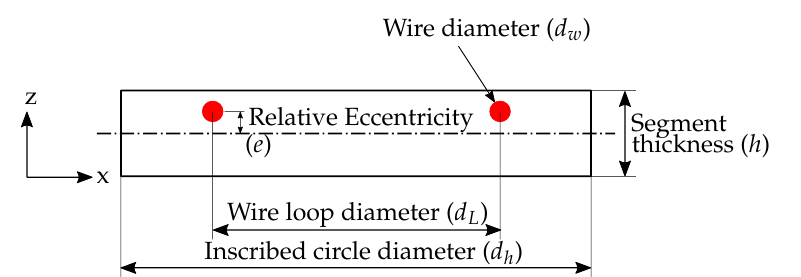
Figure A1. Geometric parameters from the cross-sectional view of the functional sample [19] .